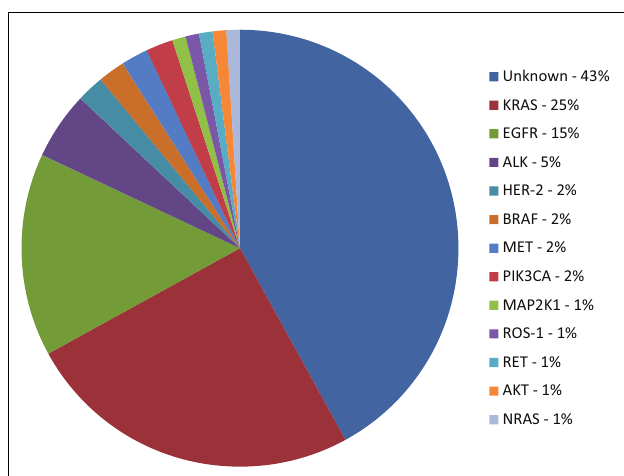
FIGURE 1 | Molecular subsets of lung adenocarcinoma . KRAS: v-Ki-ras2 Kirsten rat sarcoma viral oncogene homolog; EGFR: epidermal growth factor receptor; ALK: anaplastic lymphoma kinase fusion; HER-2: human epidermal growth factor receptor 2; BRAF: v-raf murine sarcoma viral oncogene homolog B1; PIK3CA: phosphoinositide-3-kinase, catalytic, α polypeptide; MAP2K1: mitogen-activated protein kinase kinase 1; RET: rearranged during transfection; AKT1: v-akt murine thymoma viral oncogene homolog 1; NRAS: neuroblastoma RAS viral (v-ras) oncogene homolog (4, 9, 14, 18, 24, 31,